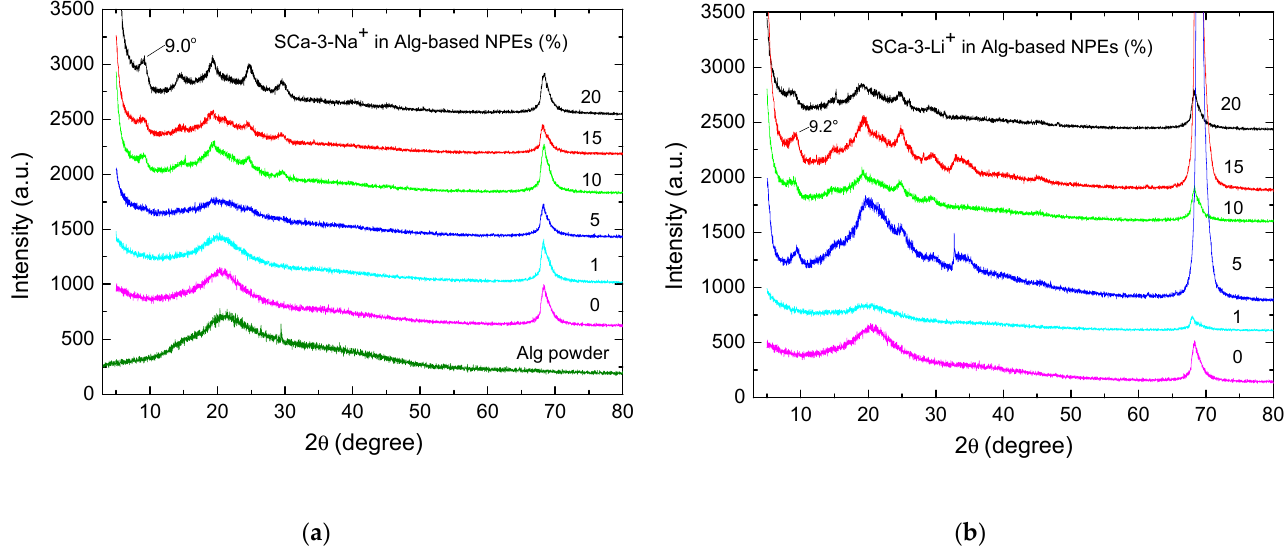
Figure 1. XRD for alginate powder, SCa-3-Na + , SCa-3-Li + clays, and Alg-based NPEs with 0–20 wt% of ( a ) SCa-3-Na + and ( b ) SCa-3-Li + .